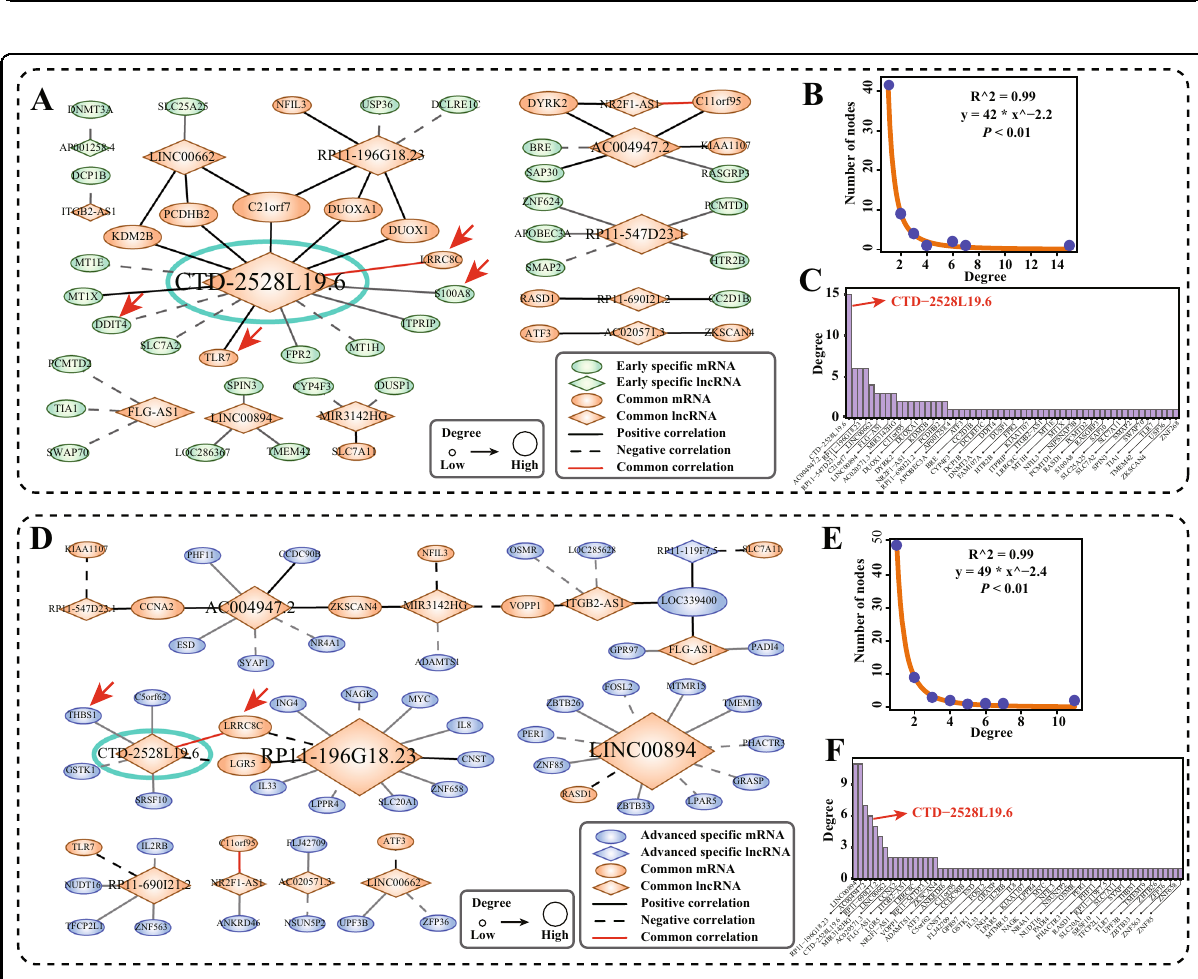
Fig. 3 IPF co-expression networks in early-stage and advanced-stage of IPF. A IPF progression lncRNAs (diamond)-mRNAs (oval) co-expression network in early-stage IPF. The solid lines (dotted lines) represent the positive (negative) correlation between mRNAs and lncRNAs (|r| >0.8, P < 0.01, P earson Correlation Test). The nodes marked with green color represent the early-stage IPF speci fi c genes. The nodes marked with yellow color represent the common genes in early-stage and advanced-stage IPF progression network. Several important IPF biomarkers and fi broblast related mRNAs that co-expressed with CTD-2528L19.6 were marked with red arrows. B , C Distribution of the degree of genes in early-stage IPF progression network. D IPF progression lncRNAs (diamond)-mRNAs (oval) co-expression network in advanced-stage IPF. The nodes marked with blue color represent speci fi c genes in advanced-stage IPF. The nodes marked with yellow color represent the common genes in early-stage and advanced- stage IPF progression network. Several important IPF biomarkers and fi broblast related mRNAs that co-expressed with CTD-2528L19.6 were marked with red arrows. E , F Distribution of the degree of genes in the advanced-stage IPF progression